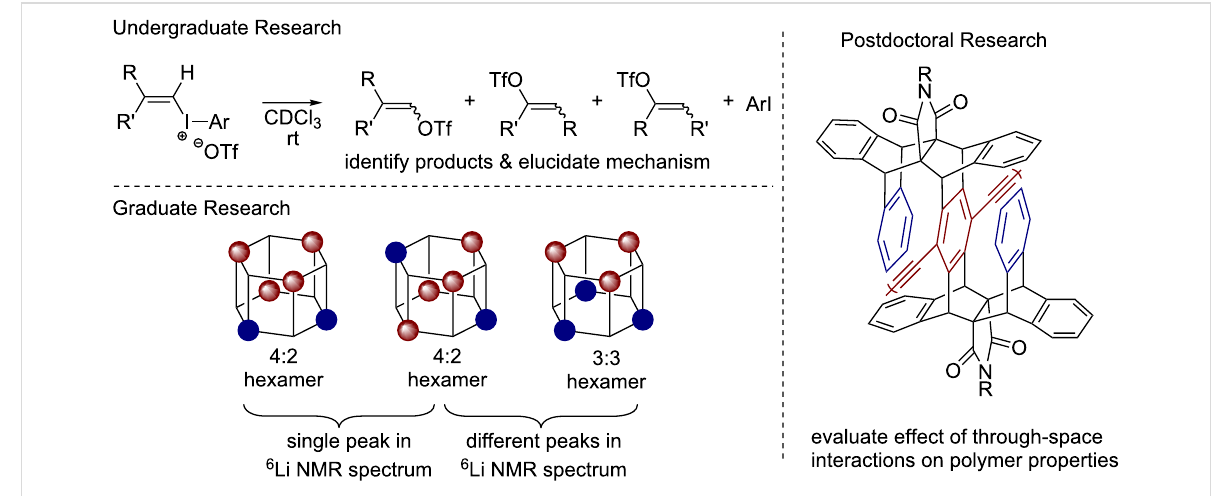
Figure 1: Summary of research experiences prior to independent